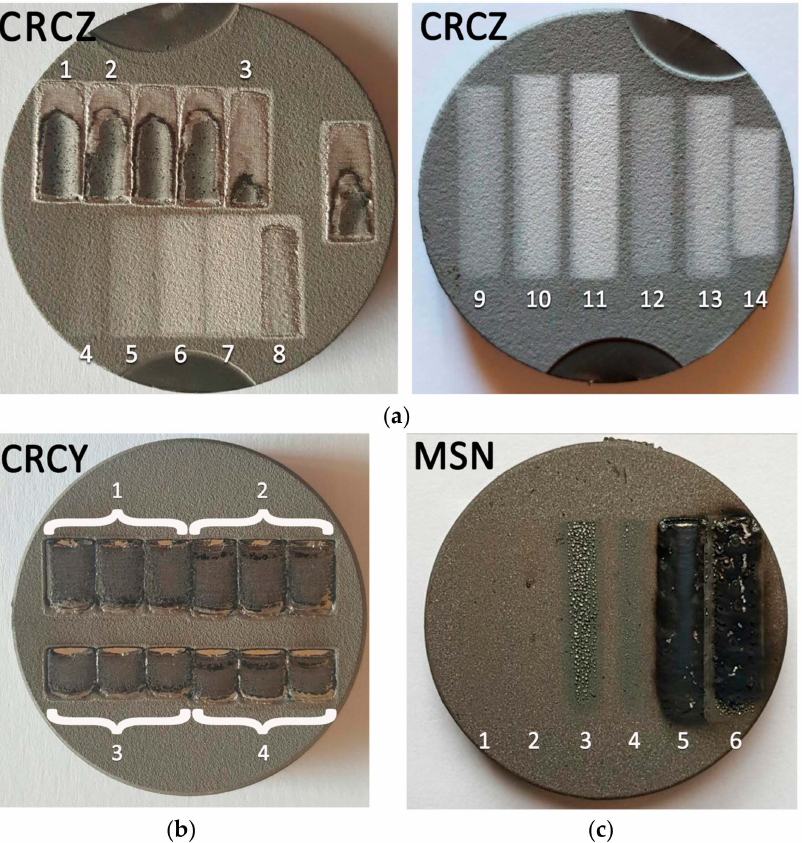
Figure 1. Laser treatment optimization tests: ( a ) CRCZ, ( b ) CRCY, and ( c ) MSN coating composition. Test numbers conditions are reported in Tables 3–5,